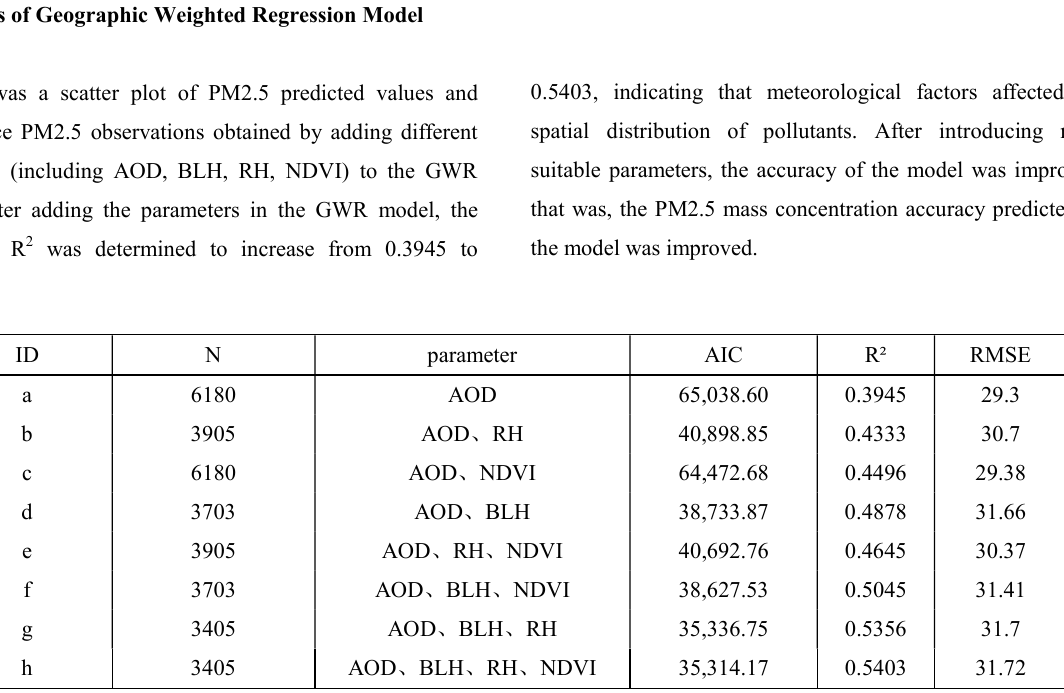
Table 2. Comparison of fitting results of different parameters in the